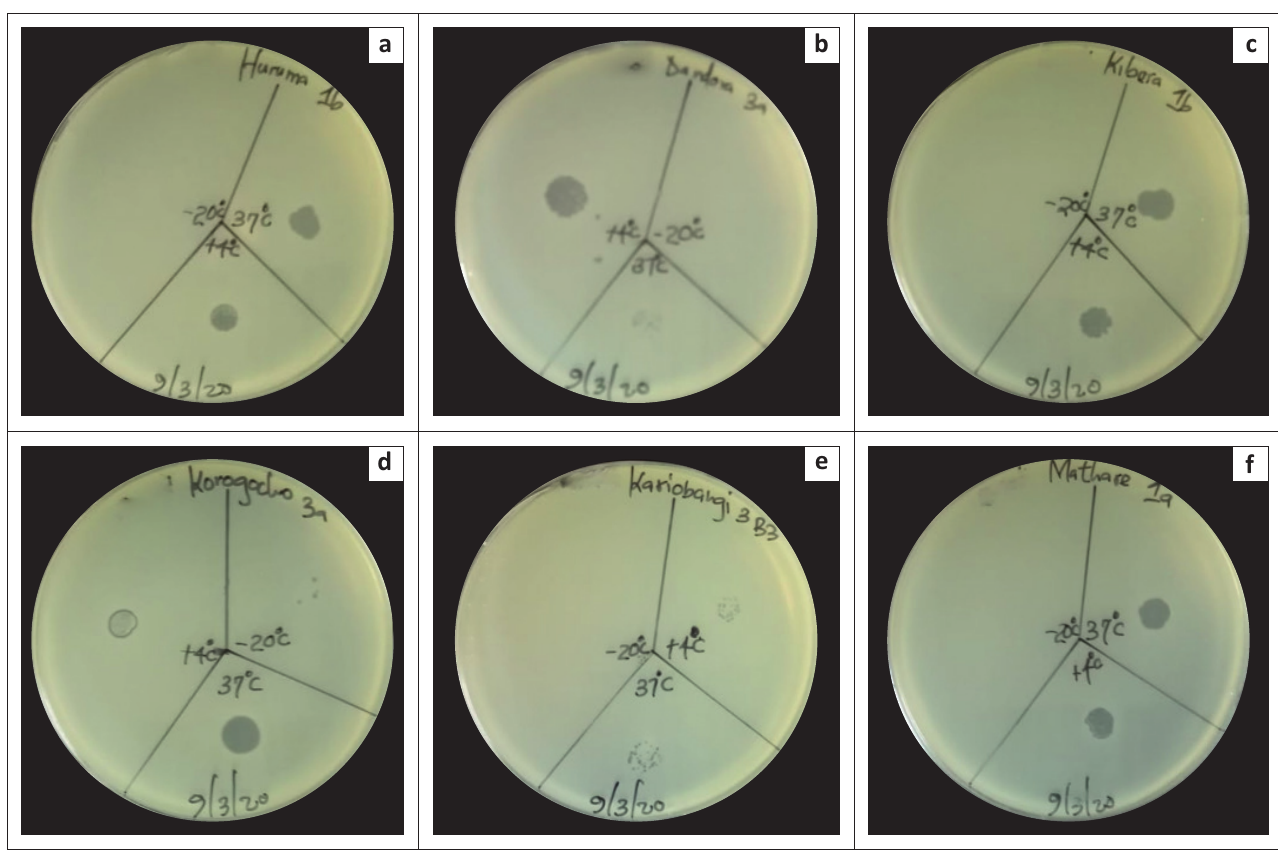
FIGURE 4: Effect of storage on phage effectiveness and stability isolated in Nairobi County, Kenya, July 2019 to December 2020. The plates show the stability and lysis activity of: (a) Huruma 1b phage, (b) Dandora 3a phage, (c) Kibera 1b phage, (d) Korogocho 3a phage, (e) Kariobangi 3b3 phage, and (f) Mathare 1a phage at 4 °C, 37 °C and −20 °C following 2 weeks of storage. These phages were isolated in Nairobi County, Kenya, between July 2019 and December 2020. The phages were stable and efficacious at 4 °C and 37 °C with minimal or no activity at −20 °C.